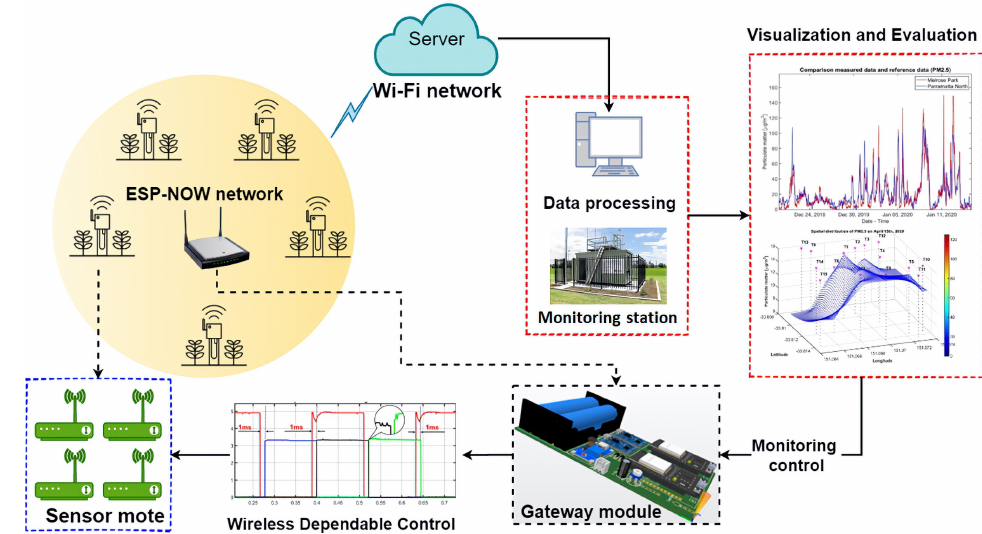
Figure 2. W-DepC framework with co-located